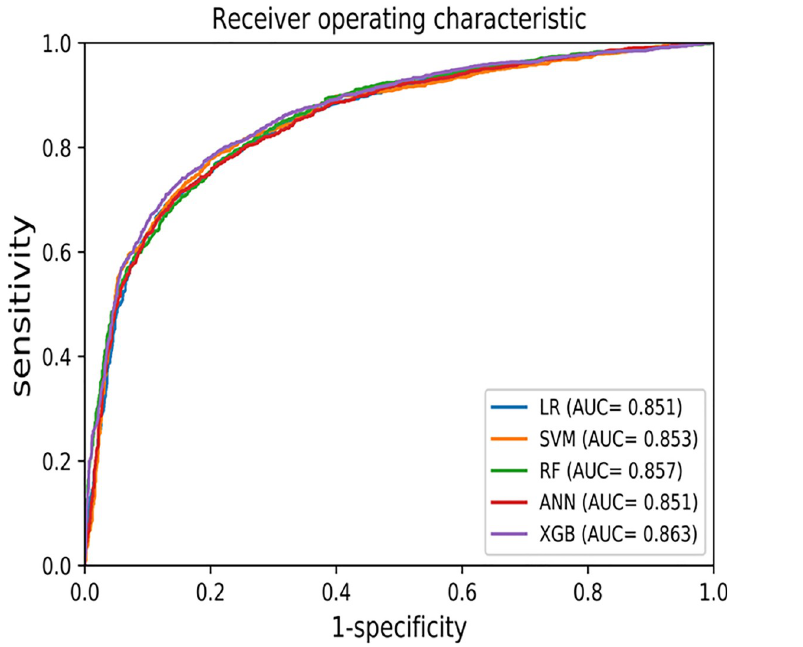
Fig 2. Receiver operating characteristic (ROC)